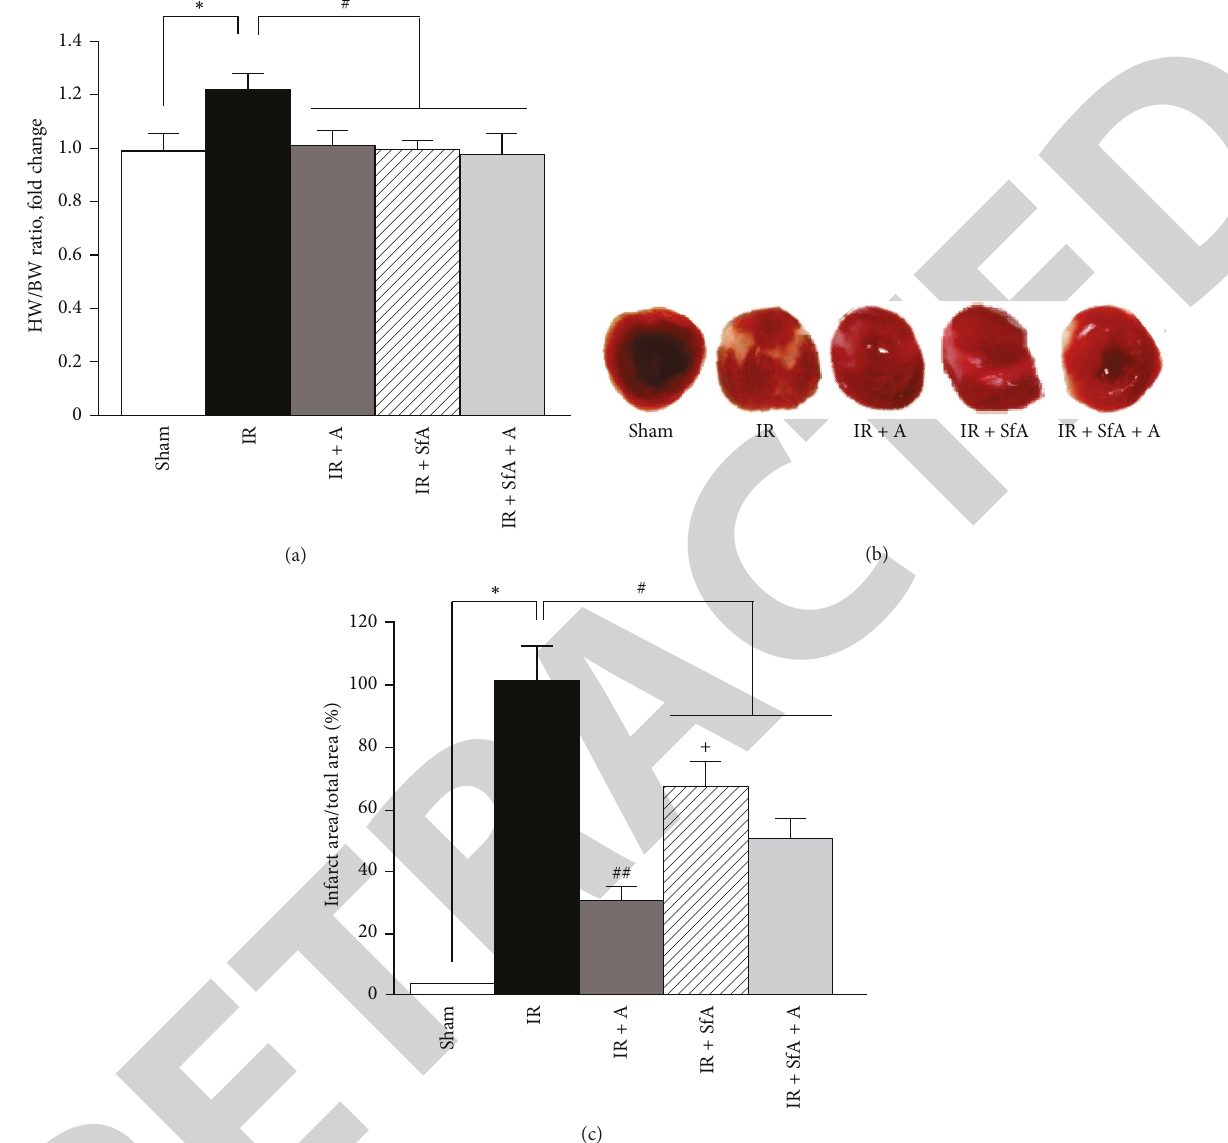
Figure 1: Effects of A-769662 (A) and/or SfA on the heart-to-body weight ratio (HW/BW) and infarct size during cardiac IR. (a) HW/BW expressed as a fold change of the Sham group; (b) representative images of heart cross sections, showing viable ( red ) and infarcted tissue ( white ) for all experimental groups; (c) quantitative results of TTC staining, expressed as percentages of the IR group. The number of animals in each group for analysis of HW/BW (a): Sham ( 𝑛 = 7 ), IR ( 𝑛 = 8 ), IR + SfA ( 𝑛 = 4 ), IR + A-769662 ( 𝑛 = 6 ), and IR + SfA + A ( 𝑛 = 4 ). Additional 3 hearts from each group were analyzed for quantification of infarction size (b and c). ∗ 𝑃 < 0.01 versus Sham; # 𝑃 < 0.05 , ## 𝑃 < 0.01 versus IR; + 𝑃 < 0.01 versus IR + A and IR + SfA +